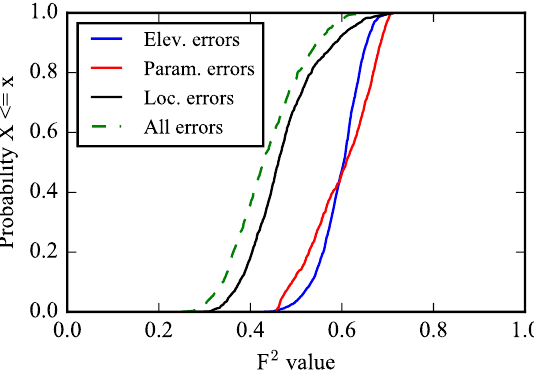
Figure 9. Empirical cumulative distribution functions of the F ( 2 ) performance statistics derived by simulating purely errors in the el- evation data (blue), errors in the parameters (red), locational errors (black) and the combination of these errors (dashed